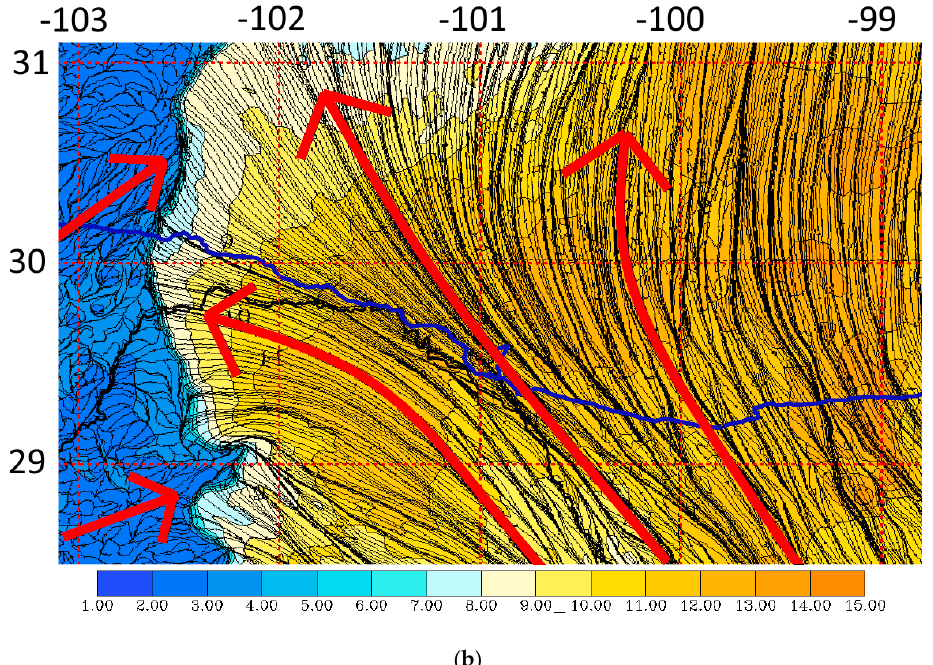
Figure 2. ( a ) Dryline positions (dashed brown lines) analyzed at 2-hourly intervals between 2100 UTC 8 April and 0300 UTC 9 April, with geographic locations mentioned in text. Westbound mobile track is highlighted in blue. ( b ) Surface specific humidity (color; g/kg) and streamlines at 2100 UTC on 8 April 2017 from high-resolution rapid refresh (HRRR).